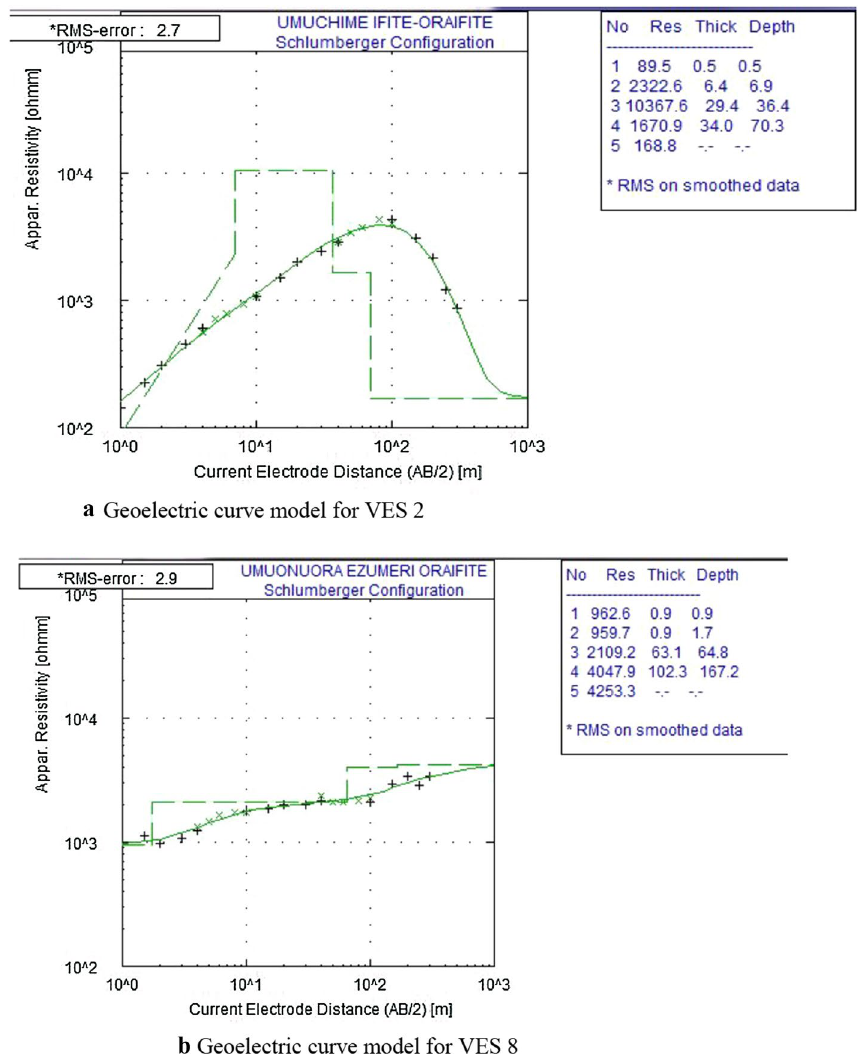
Fig. 2 a Geoelectric curve model for VES 2. b Geoelectric curve model for VES